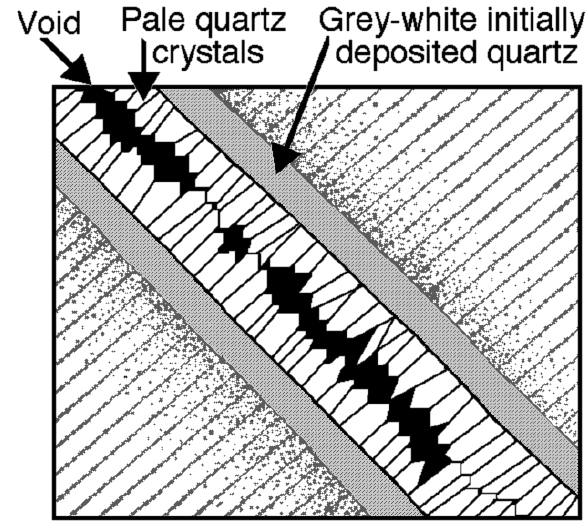
Figure 47. A typical pattern of druse cavities in a quartz vein illu- strates how the polymeric silica initially silicifies wall rocks and fills the whole vein space. It then contracts to central watery silica gel into which the large quartz crystals grow until essentially water or salt water is left in the